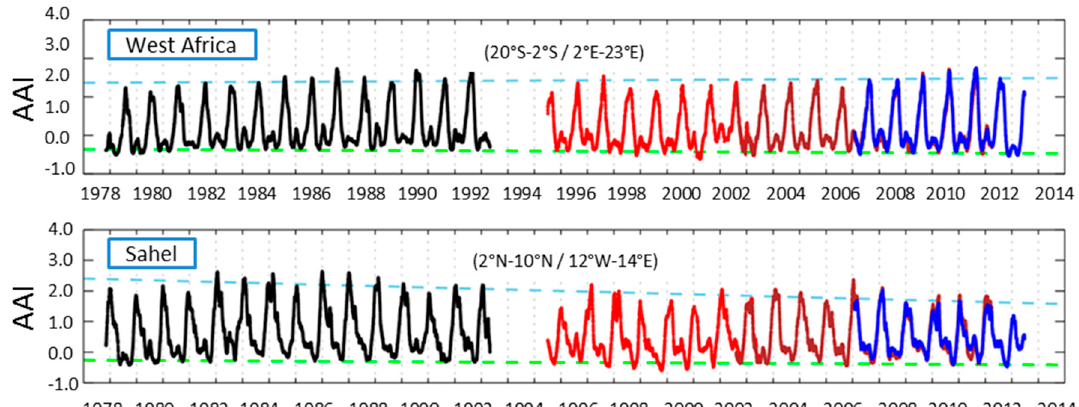
Figure 12. Time series of regional mean AAI for two aerosol regions. The geographical extent of the regions is provided in the plot windows. Different instruments are shown in different colors (TOMS: black, GOME-1: red, SCIAMACHY: brown, GOME-2: blue; OMI is not shown). The dashed green lines represent linear fits to the yearly minima of the time series to characterize the stability of the data record (in the absence of aerosol) for that particular region. The dashed light blue lines represent linear fits to the yearly maxima of the time series to represent trends in aerosol presence for the considered regions.